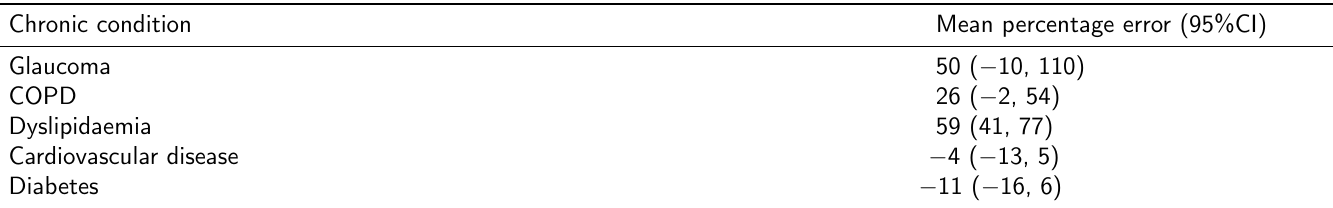
Table 4: Comparison of mean percentage error between PBS prevalence estimates and National Health Survey data for persons